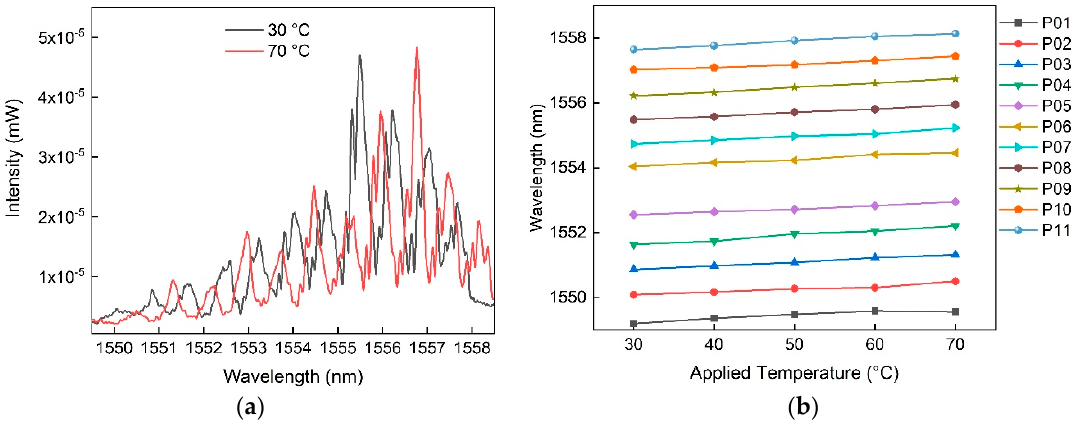
Figure 5. Reflection spectrum of etched GI-MMF with BG for the measurement of different surrounding temperatures ( a ) and the response of the individual Bragg reflection peaks to different applied temperature values ( b ) P01–P11 indicate the Bragg reflection peaks in the reflection spectrum from the left to the right, i.e., the Bragg reflection peak of the highest PMG is marked with P01 , whereas the Bragg reflection peak of the lowest PMG is marked with P11 . Table 2. Sensitivities of the different Bragg reflection peaks to applied temperature.